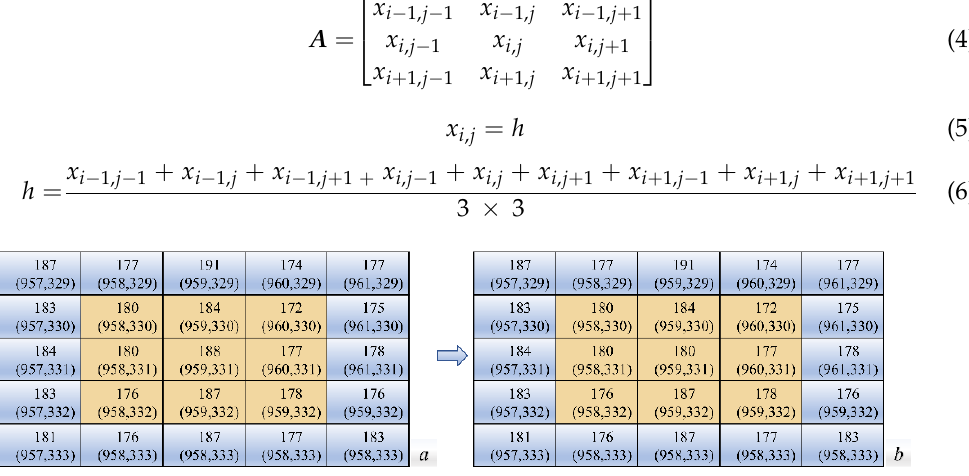
Figure 5. Image digital matrix. ( a ) Image digital matrix before median filtering. ( b ) Image digital matrix after median filtering. matrix after median